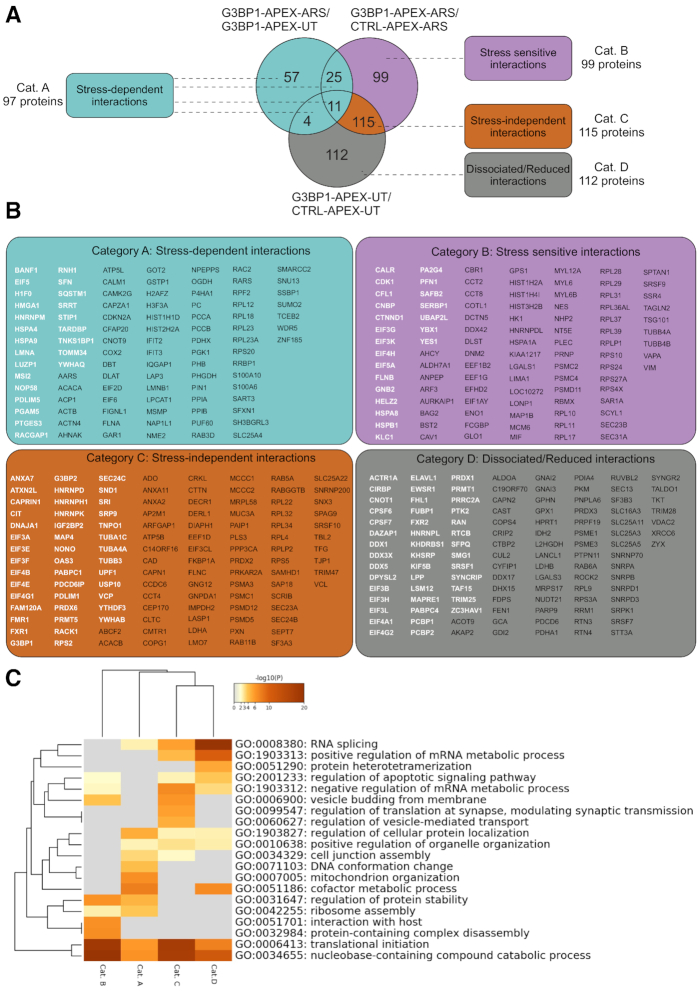
G3BP1-associated proteins and pathway analysis. (A) Venn diagram showing a comparison and categorization (4 categories) of G3BP1-associated proteins in unstressed and arsenite stressed cells (see text for more details). (B) Proteins that come under the above different categories are listed in boxes with the corresponding colour shades. SG/G3BP1-interacting proteins, already reported in the literature are shown in white letters and new proteins identified in the current study are shown in black letters. (C) Gene ontology analysis using the above four categories of proteins using Metascape software (http://metascape.org).